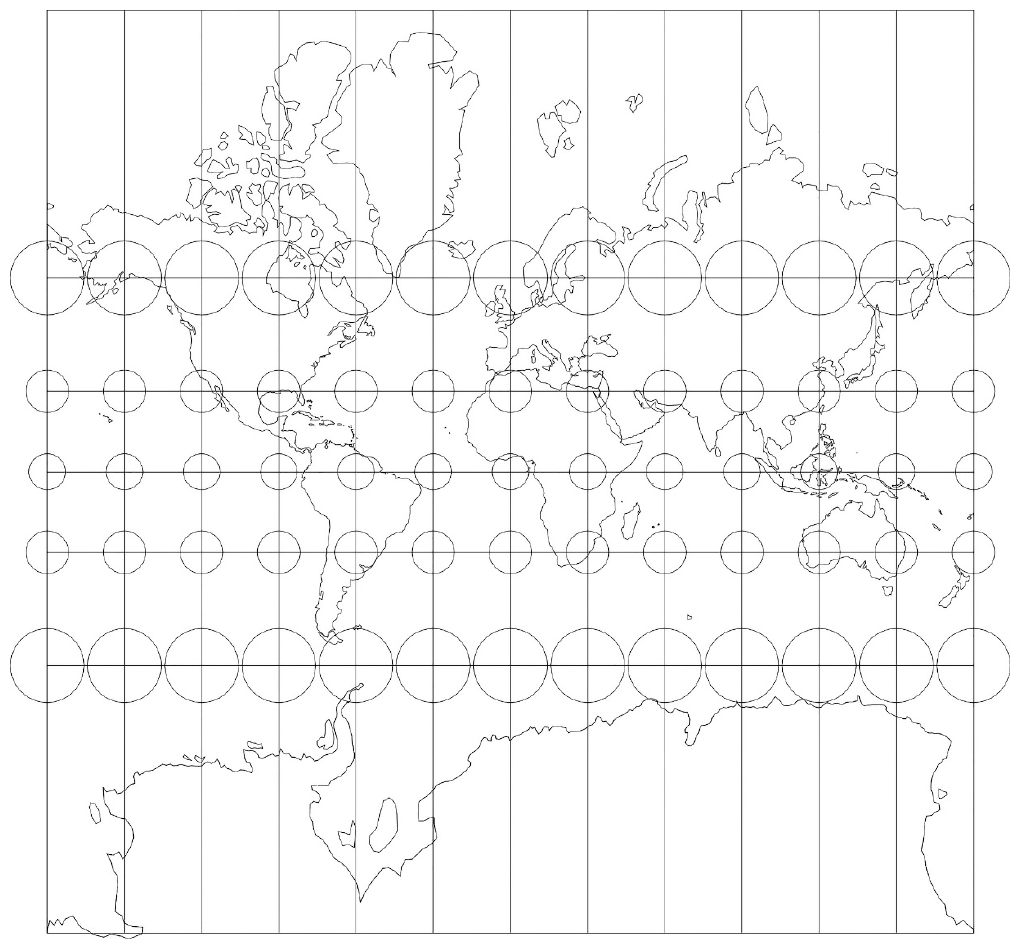
Figure 1. Mercator map projection with as overlay the Tissot indicatrix.